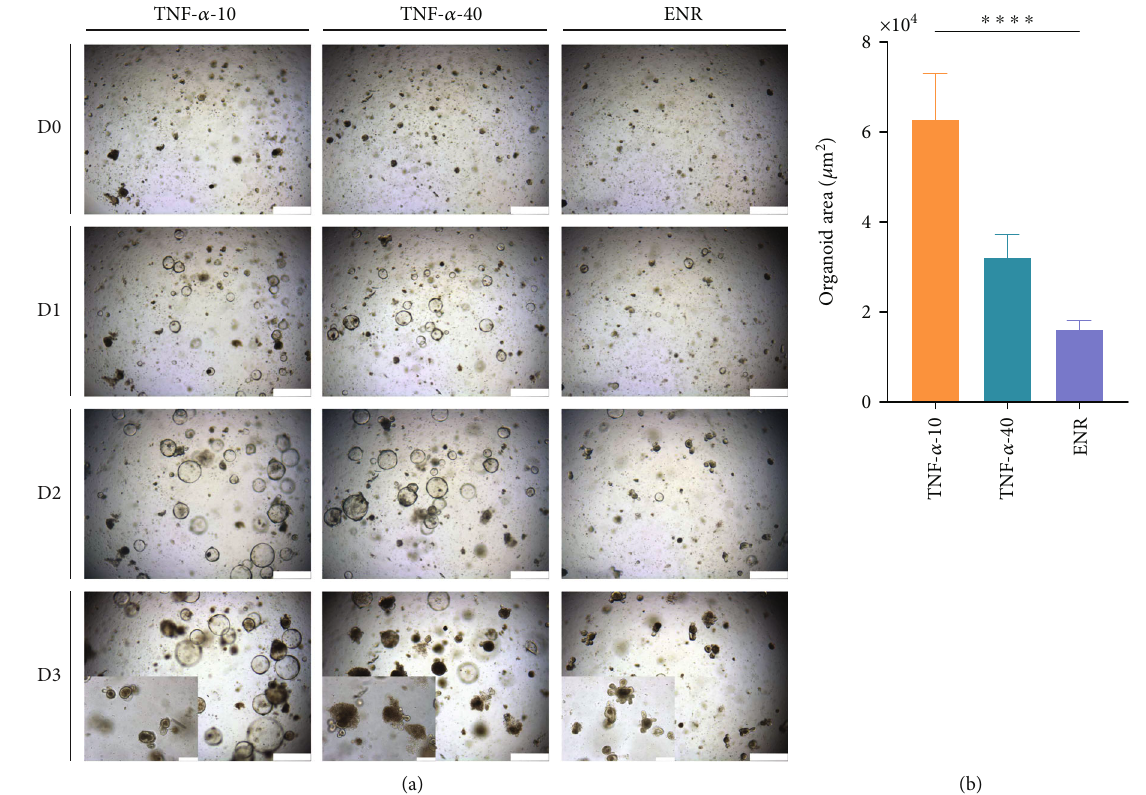
Figure 6: Intestinal organoids with di ff erent concentrations of TNF- α treatment. (a) Images of intestinal organoids with di ff erent concentrations of TNF- α treatment. TNF- α -10 (dose: 10ng/mL; fi rst column), TNF- α -40 (dose: 40 ng/mL; second column), and untreated control (ENR, third column). Images taken continuously for 3 days of culture: day 0 ( fi rst row), day 1 (second row), day 2 (third row), and day 3 (fourth row). Scale bars = 500 μ m. Bottom left corners displayed a zoomed-in intestinal organoids. Scale bars = 200 μ m. (b) The organoid area with di ff erent concentrations of TNF- α treatment. P values were determined by one-way ANOVA. ∗ P < 0 : 05 ; ∗∗ P < 0 : 01 ; ∗∗∗ P < 0 : 001 . The experiments were independently repeated at least three times with similar